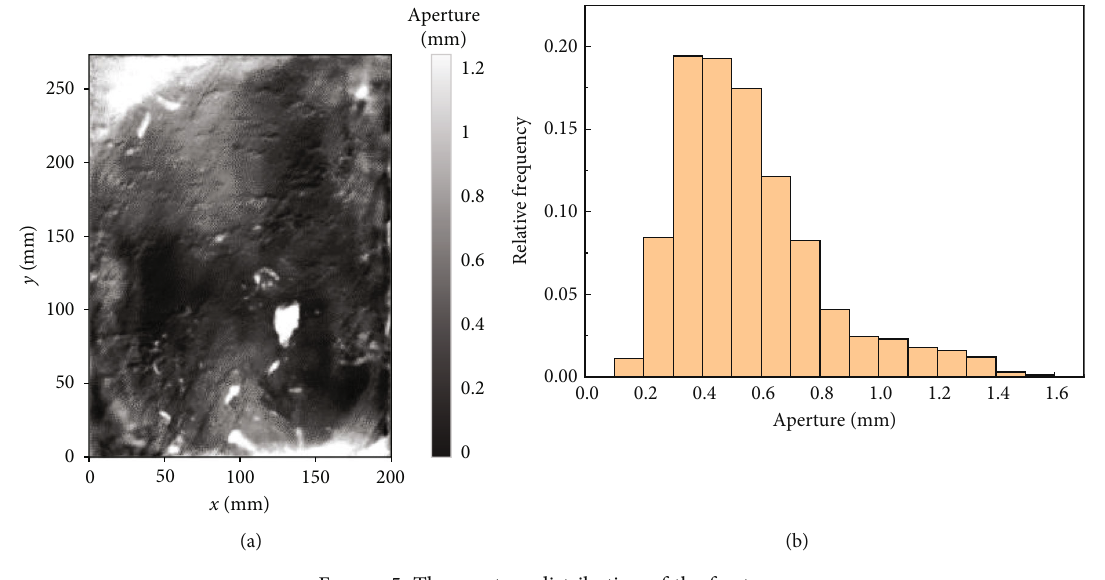
Figure 5: The aperture distribution of the fracture.